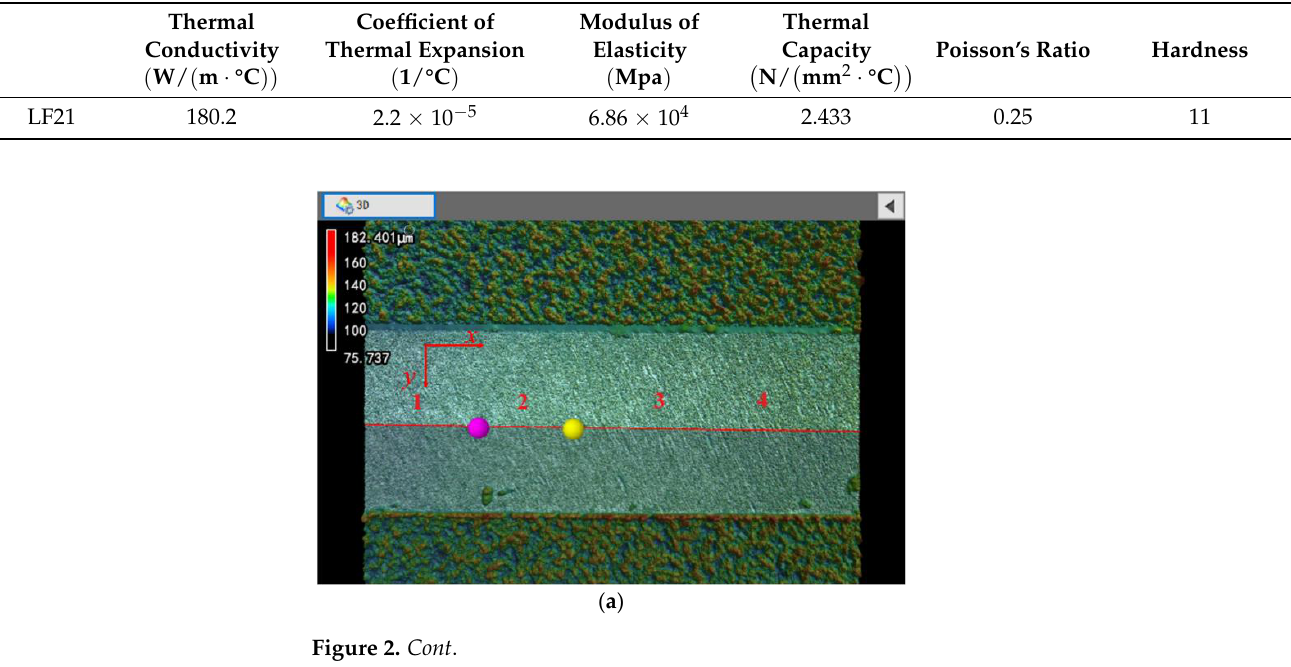
Figure 1. The micro-milling machine tool. Table 1. Materials composition of LF21.